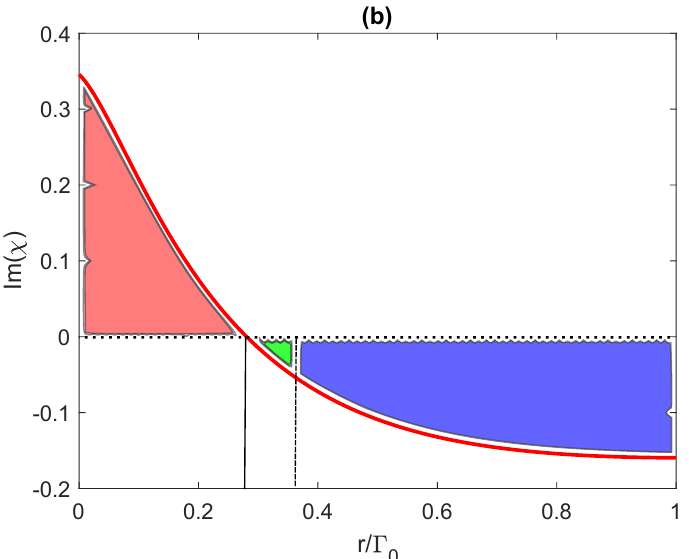
Figure 6. ( a ) The population distributions ρ 11 , ρ 22 and ρ 33 , ( b ) and the gain spectrum [ Im ( χ ) ] (in 2 units of N µ ) of the quantum V -system as a function of the incoherent pumping r in the presence of a ε 0 ¯ h plasmonic nanostructure. We take here ω 32 = 0.25 Γ 0 , and δ = 0.2 Γ 0 and d = 0.8 c / ω c . The horizontal dotted line indicates the zero absorption limit, while the vertical dashed (solid) line indicates the limit for the incoherent pumping to achieve the population inversion r PI place in r < r L (the red zone in ( b )). Gain without inversion appears in r L T in ( b )), while the lasing with inversion takes place when r > r PI